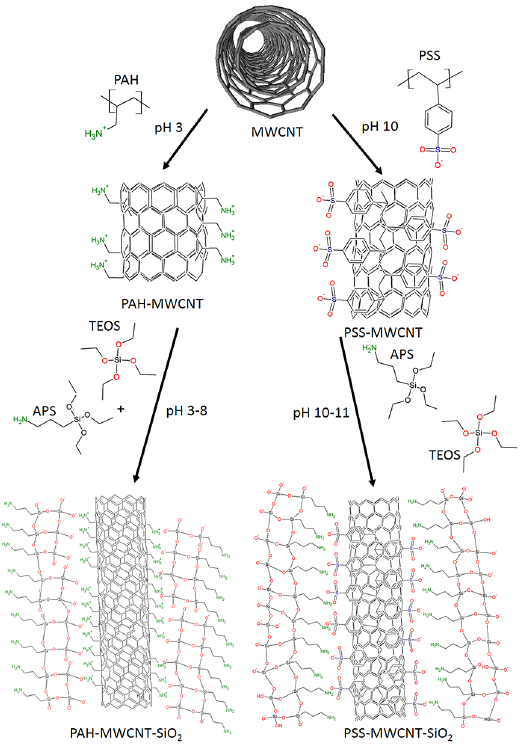
Figure 3. Schematic representation of the two synthetic routes used for the preparation of the PAH-MWCNTs-SiO including the functionalization with polyelectrolytes PAH and PSS.